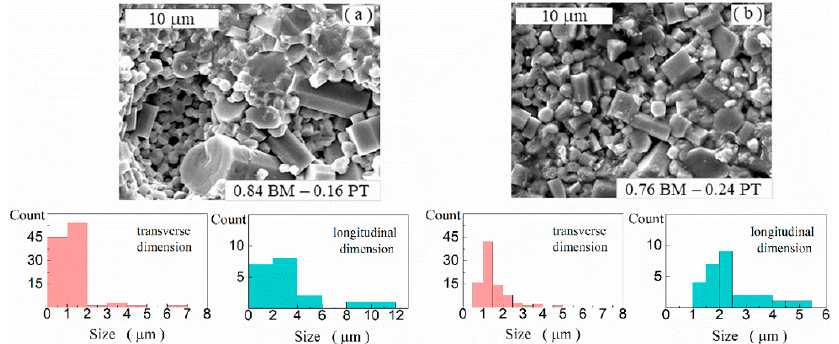
Figure 4. Secondary electron images obtained for 0.84 BM–0.16 PT ceramics ( a ) and 0.76 BM–0.24 PT ceramics ( b ). Histograms show grains’ transverse and longitudinal size distribution.